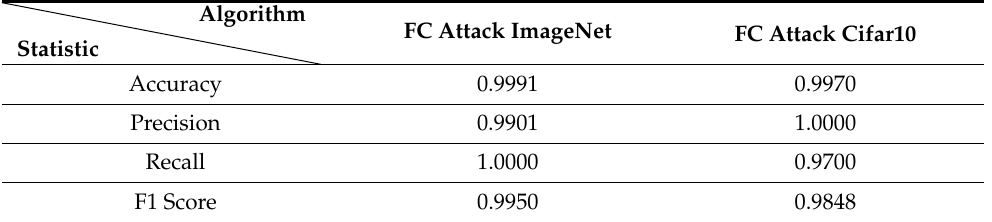
Table 8. IDA detection algorithm performance for FC attacks against ImageNet and Cifar datasets. (Note that target attack detection threshold is 0.5.).